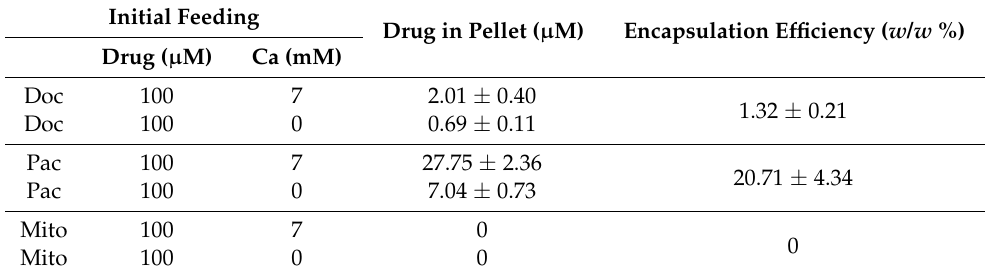
Table 2. Estimated loading efficiency of nanoparticles for Pac, Doc, and mitomycin C by HPLC analysis. Initial